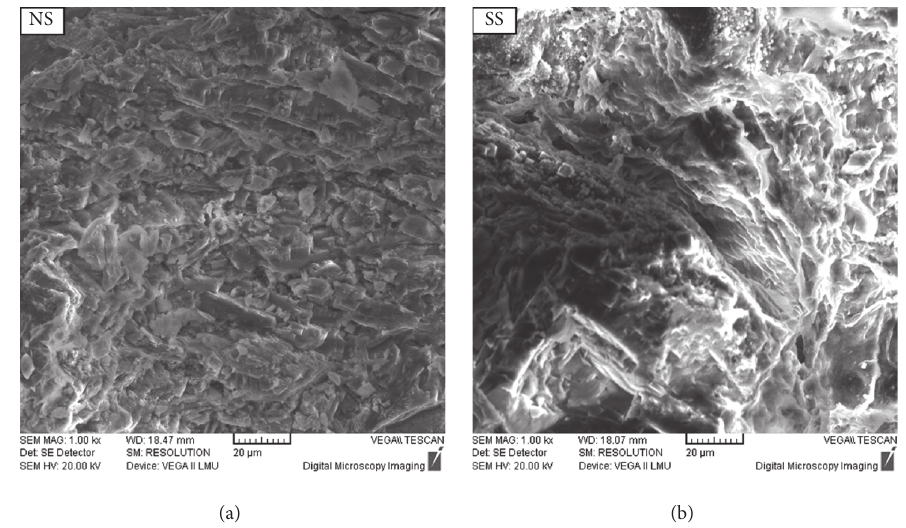
Figure 12: SEM graphics of natural and saturated sandstones.